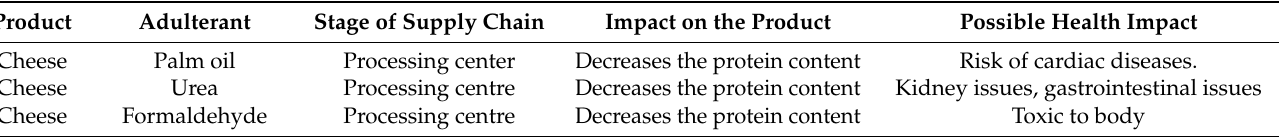
Table A1. Type of adulterants in cheese and their impacts on health and